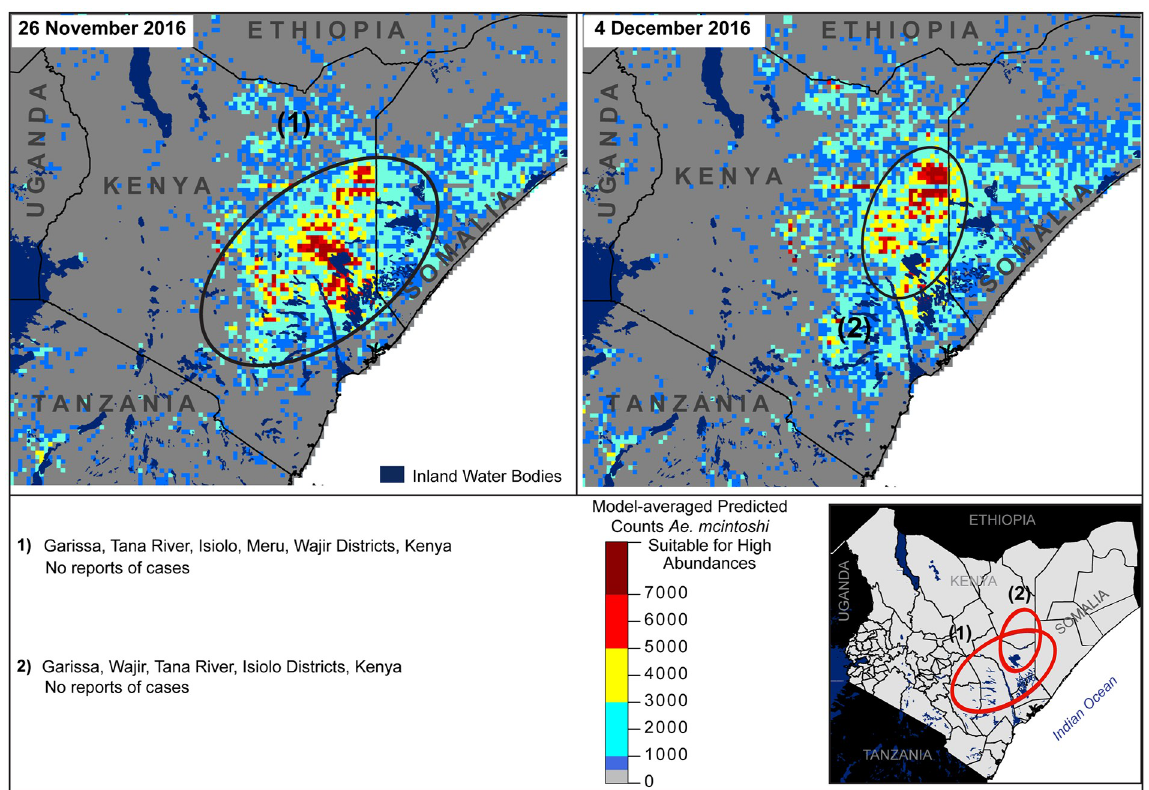
Fig 7. Predicted elevated abundance during late November (left panel) and early December 2016 (right panel); no virus activity reported, widespread vaccination occurred in 2015/2016 short rains season. District boundaries fall inside circles in the lower right panel, with corresponding information provided below the panel